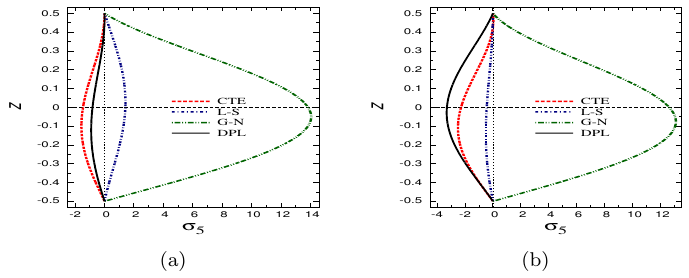
the smallest shear stress for thermomechanical loaded beams. Figure 13 shows the through-the-thickness variation of the dimensionless transverse shear stress σ 5 at the first edge x = 0 of the beam. The behavior of the transverse shear stresses for the two cases may be the same. Just the first case enlarges